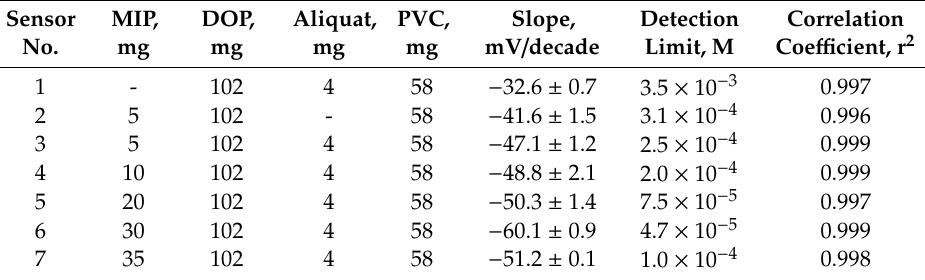
Table 1. Potentiometric characteristics of the proposed